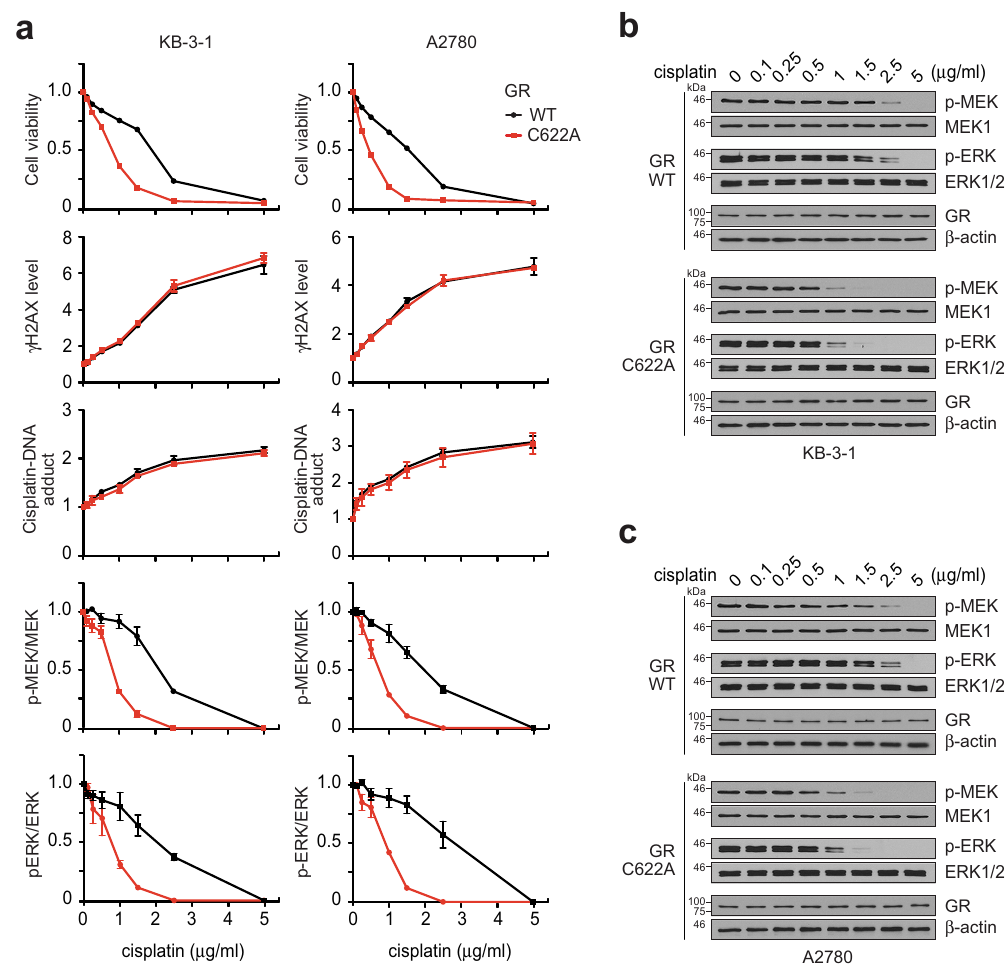
Fig. 6 GR C622 is crucial for cisplatin resistance through MEK-ERK activation but not DNA damage response. a Dose-dependent analyses of cell viability, γ H2AX, cisplatin-DNA adduct, MEK and ERK phosphorylation in KB-3-1 and A2780 cells carrying GR WT or C622A upon cisplatin treatment. b , c Representative Western blot of MEK-ERK pathway change in KB-3-1 ( b ) and A2780 ( c ) cells carrying GR WT or C622A upon treatment with increasing concentrations of cisplatin. Data are from three independent experiments and mean ± SEM for blot analyses and mean ± SD for others. Source data are provided as a Source Data fi